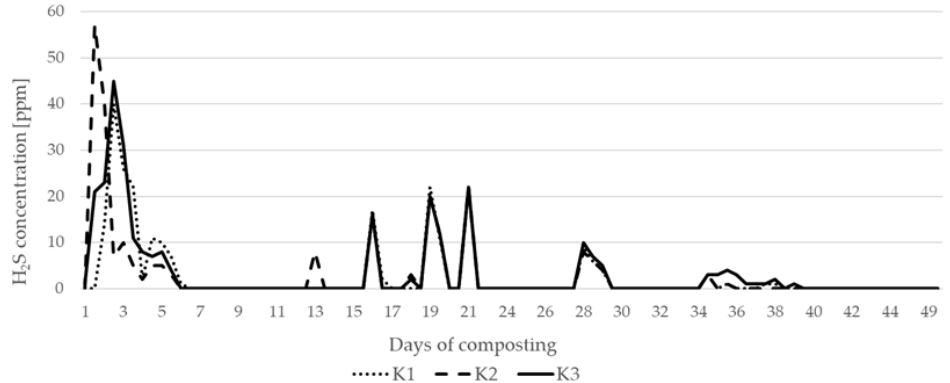
Figure 8. The concentration of hydrogen sulfide in the analyzed composts.